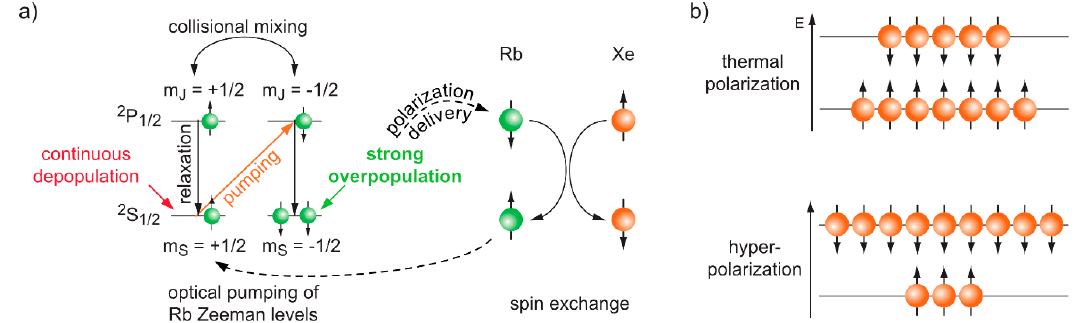
Figure 3. Hyperpolarization of 129 Xe through SEOP. ( a ) Optical pumping of the Rb electron system and subsequent spin transfer onto Xe in a binary collision. ( b ) Enhanced population difference in the hp spin system compared to the condition with thermal polarization. In this case, the pumped Rb system causes an overpopulation of the upper Xe spin energy level. The eventually detected signal is proportional to the polarization P and the spin density.